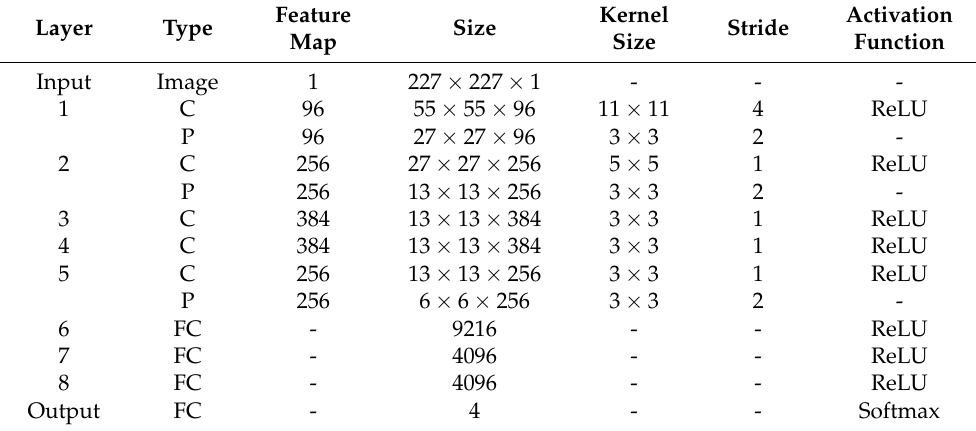
Table 2. Description of AlexNet architecture (C—convolutional layer, P—Max pooling, and FC—fully